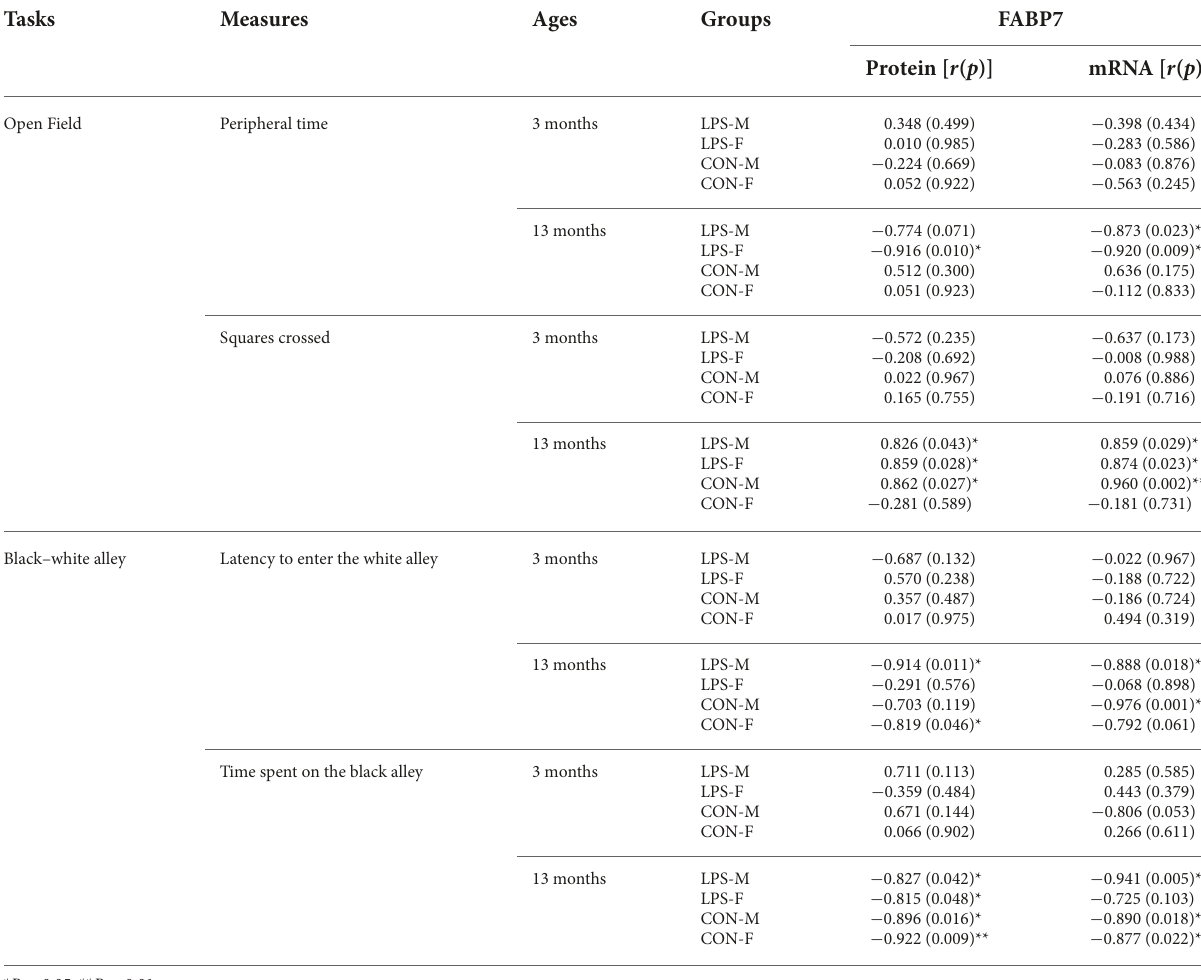
TABLE 3 Correlations between performance in anxiety-related tasks and hippocampal FABP7 protein and mRNA levels in F1 offspring. Tasks Measures